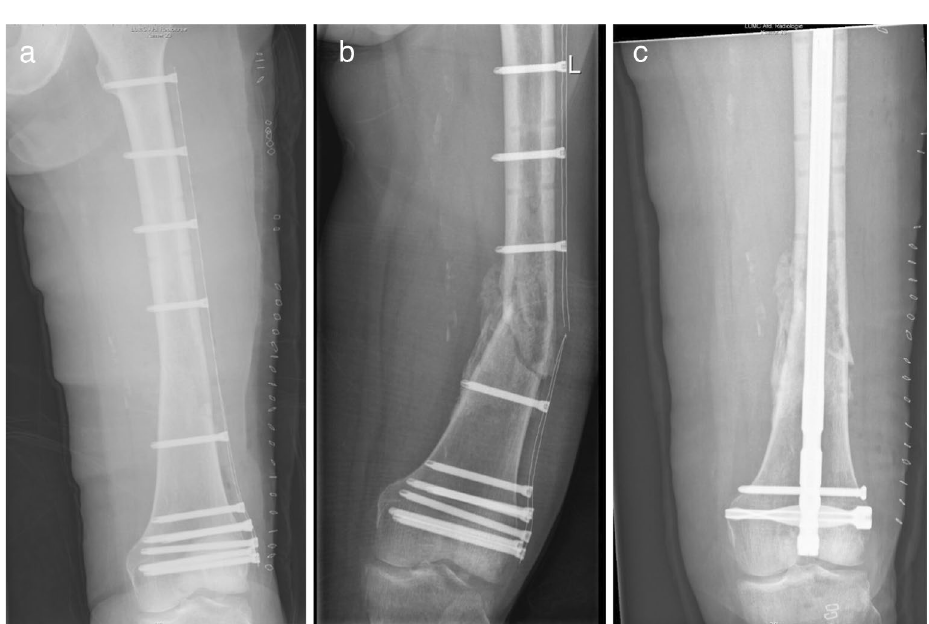
Figure 6. Carbon-fiber plate after pathological fracture of the left distal femur due to a diffuse large B-cell lymphoma ( a ). Plate breakage, exactly at the location of the pathological fracture at 5 months after surgery ( b ). Status after revision with a conventional retrograde femoral nail ( c ). Pseudoarthrosis remained, and this patient died of disease 1-year after the carbon-fiber plate revision with a conventional retrograde femoral nail. In general, an intramedullary osteosynthesis of lower extremity pathological fractures is preferred because steel plates are expected to break when fracture healing is not